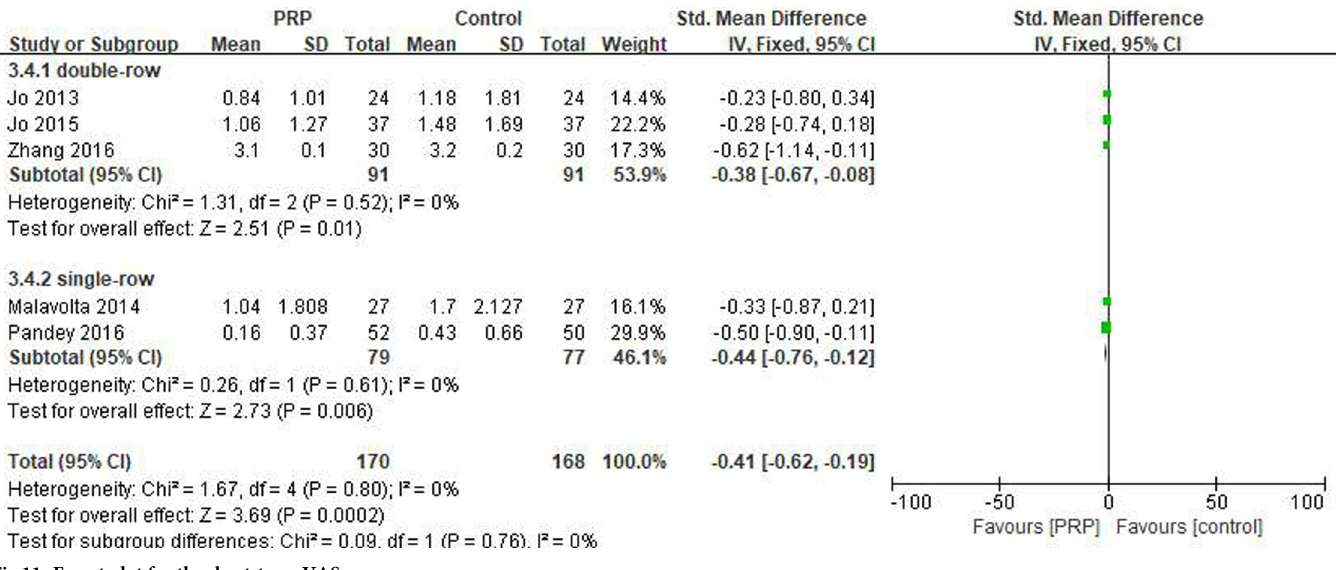
Fig 11. Forest plot for the short-term